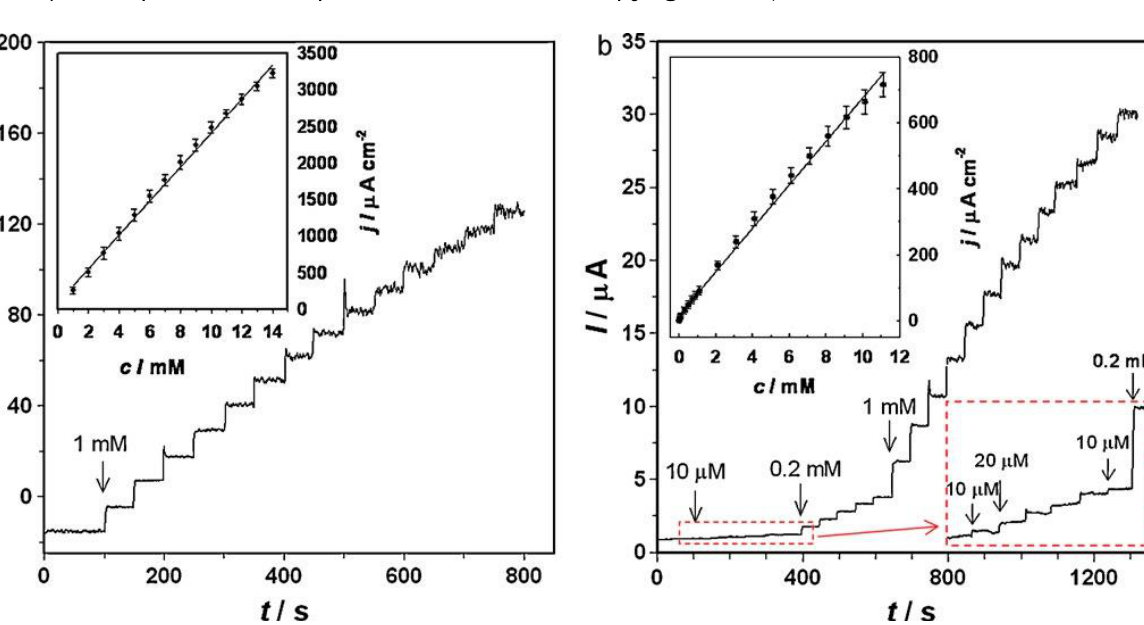
Figure 6. Amperometric responses of the NPGF (Nano porous gold film) electrode to successive addition of glucose in a continuously stirred solution of 0.1 M PBS (Phosphate buffer) (pH 7.4) containing ( a ) 0.1 M Na